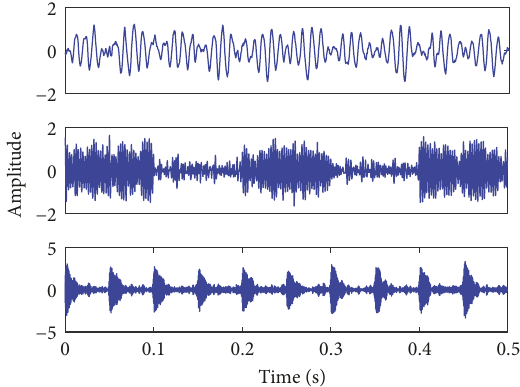
Figure 7: Decomposition results obtained by CELMDAN.